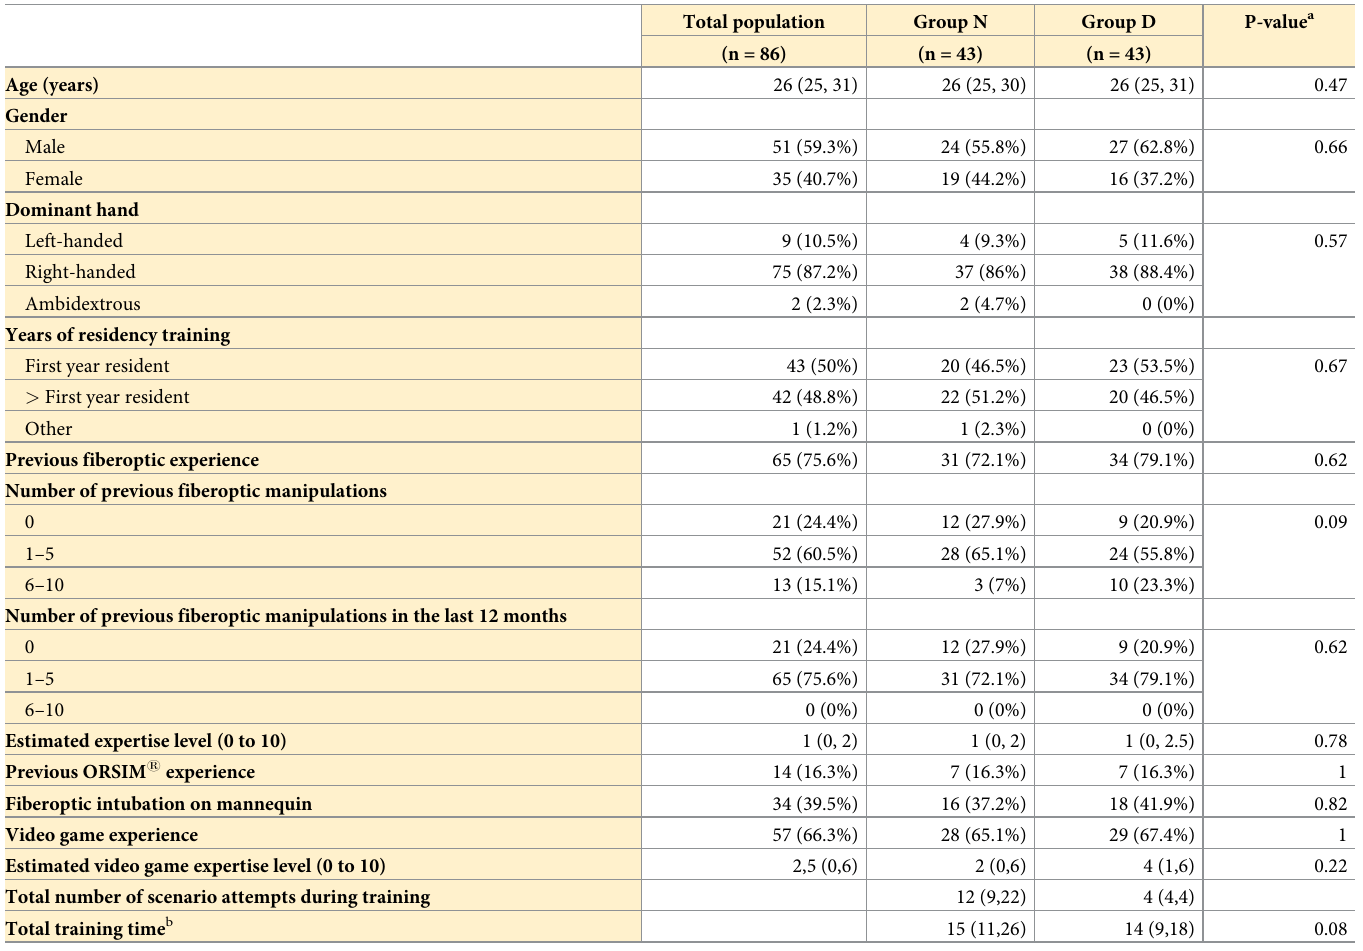
Table 1. Demographic